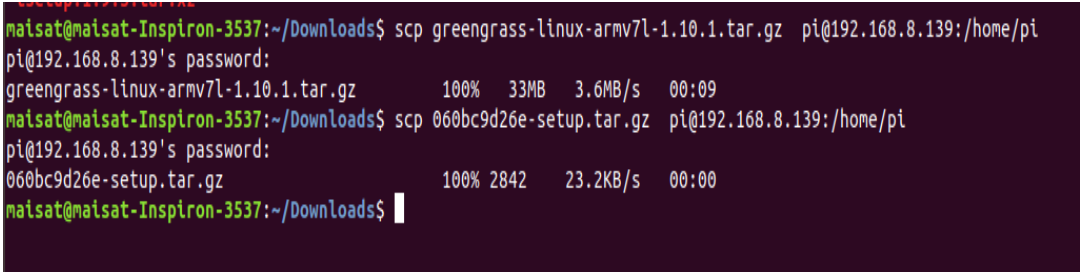
Figure 9. The Raspberry Pi 4 kit setup.